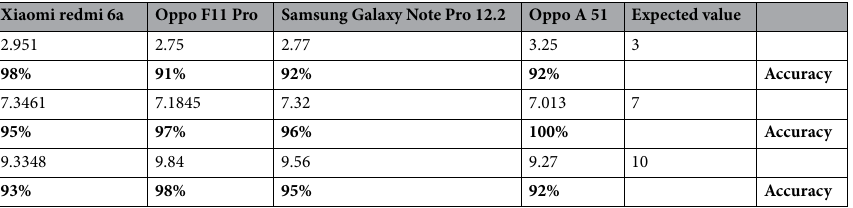
Table 3. Accuracy and estimated pH value from different smartphones. Significant values are in bold.